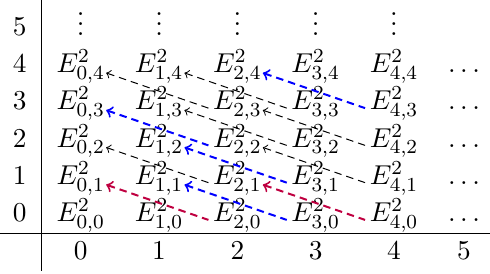
Table 3 . Example of a second page E 2 of a first quadrant homological spectral sequence and all possible d 2 differentials. The non-vanishing d 2 are shown by purple and blue arrows.